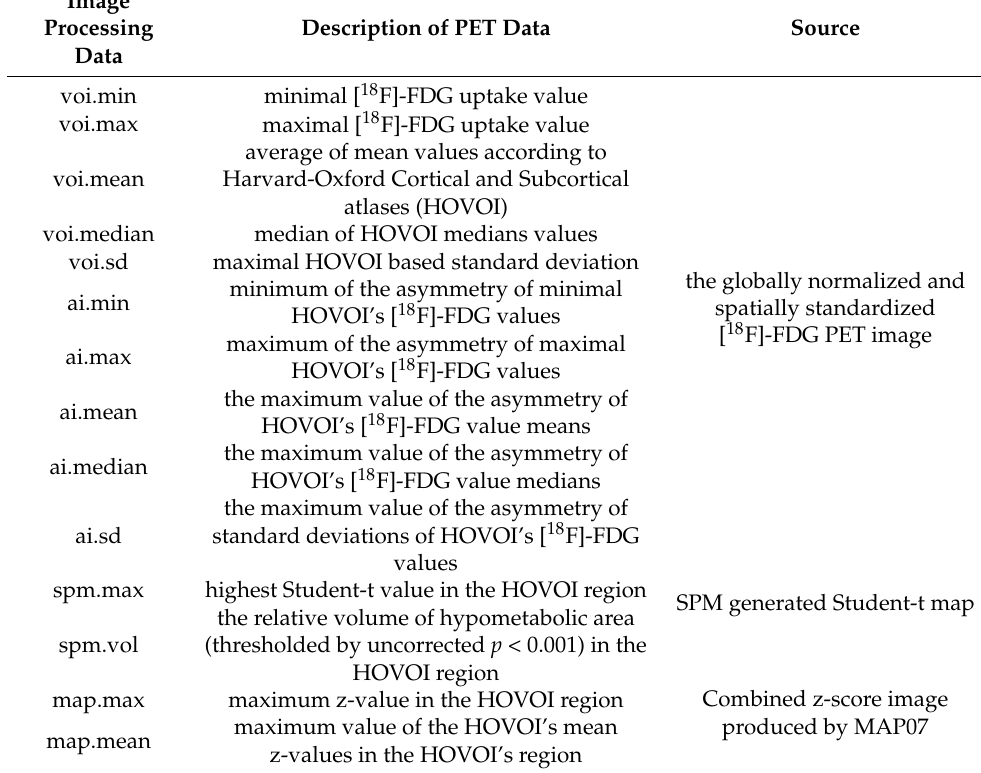
Table 2. Evaluated quantitative [ 18 F]-FDG PET image-processing